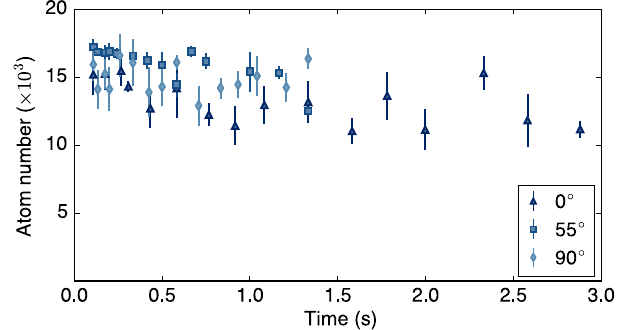
FIG. 7. Atom number during the momentum evolution at γ VdW ; avg ¼ 5 . 7 ð 7 Þ for θ ¼ 0 ° (triangle), 55° (square), and 90° d